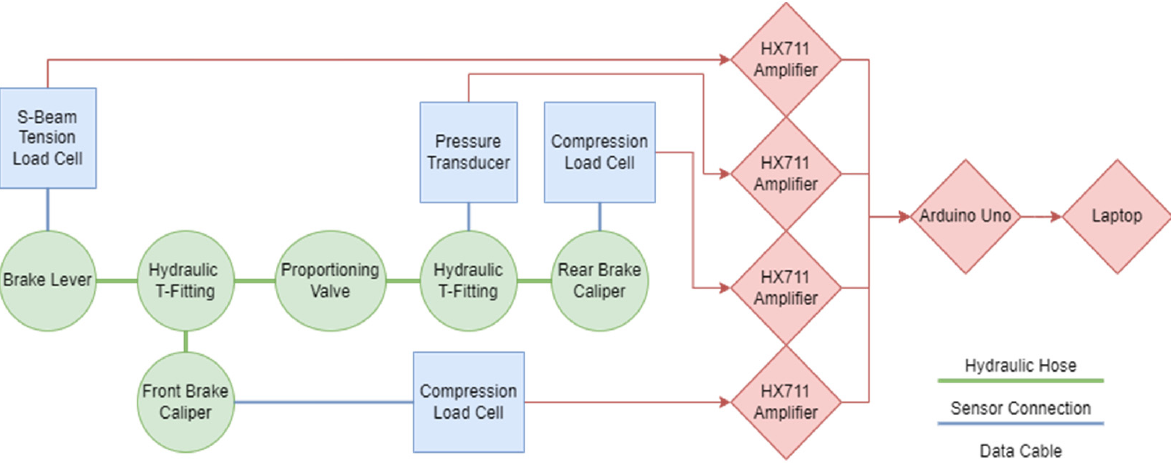
Figure 1. Test layout for the prototype hydraulic brake system with proportioning. This includes force and pressure sensors along with the data acquisition equipment.